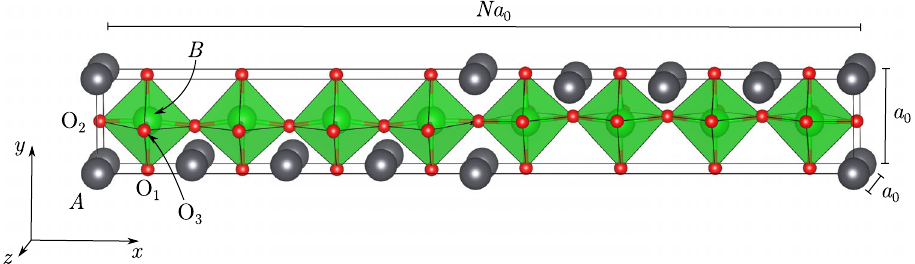
FIG. 2. Example of unit cell used in some of our full-DFT calculations (here, N ¼ 8 , and domains with opposite orientations give rise to an A O-type domain wall).